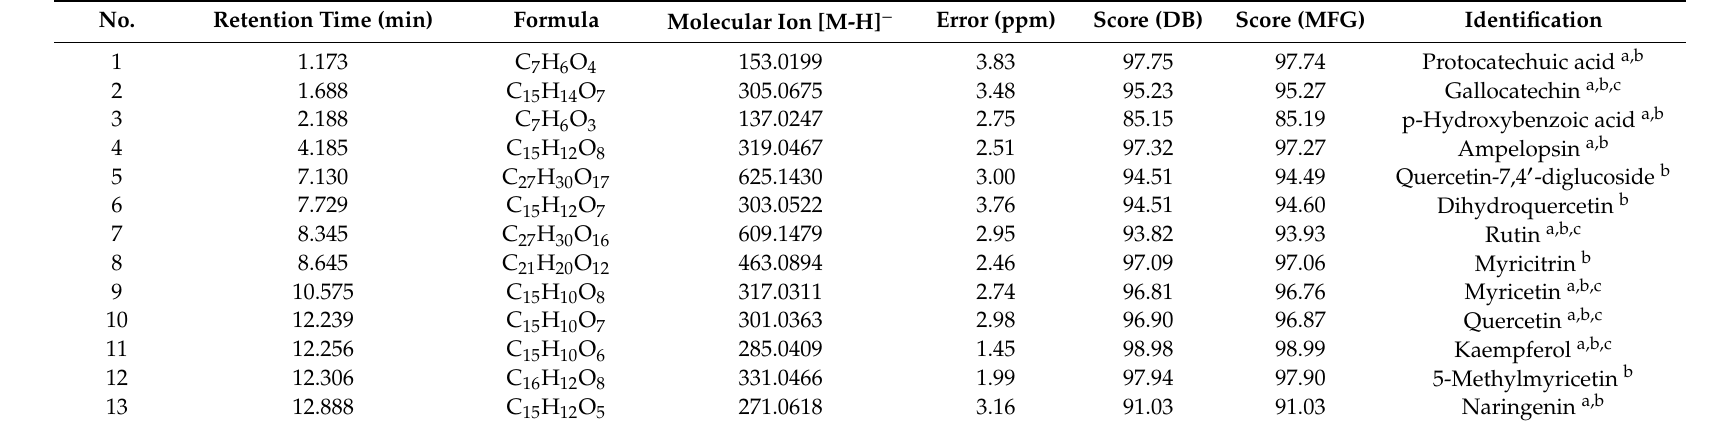
Table 4. Phenolic compositions of